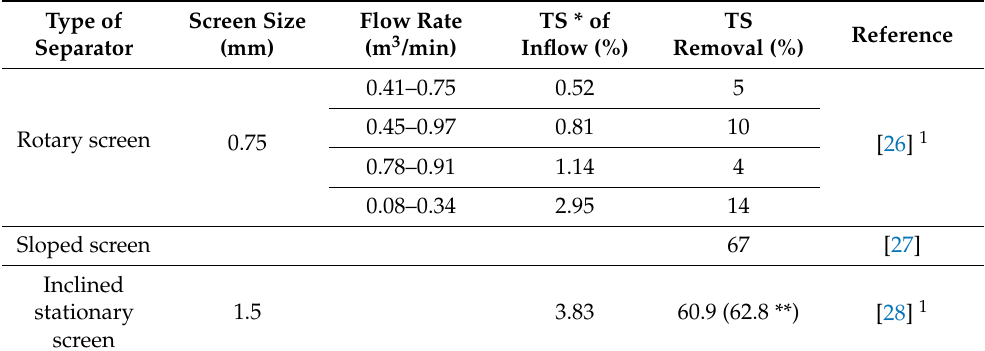
Table 1. A comparison of selected screen separators for dairy manure.